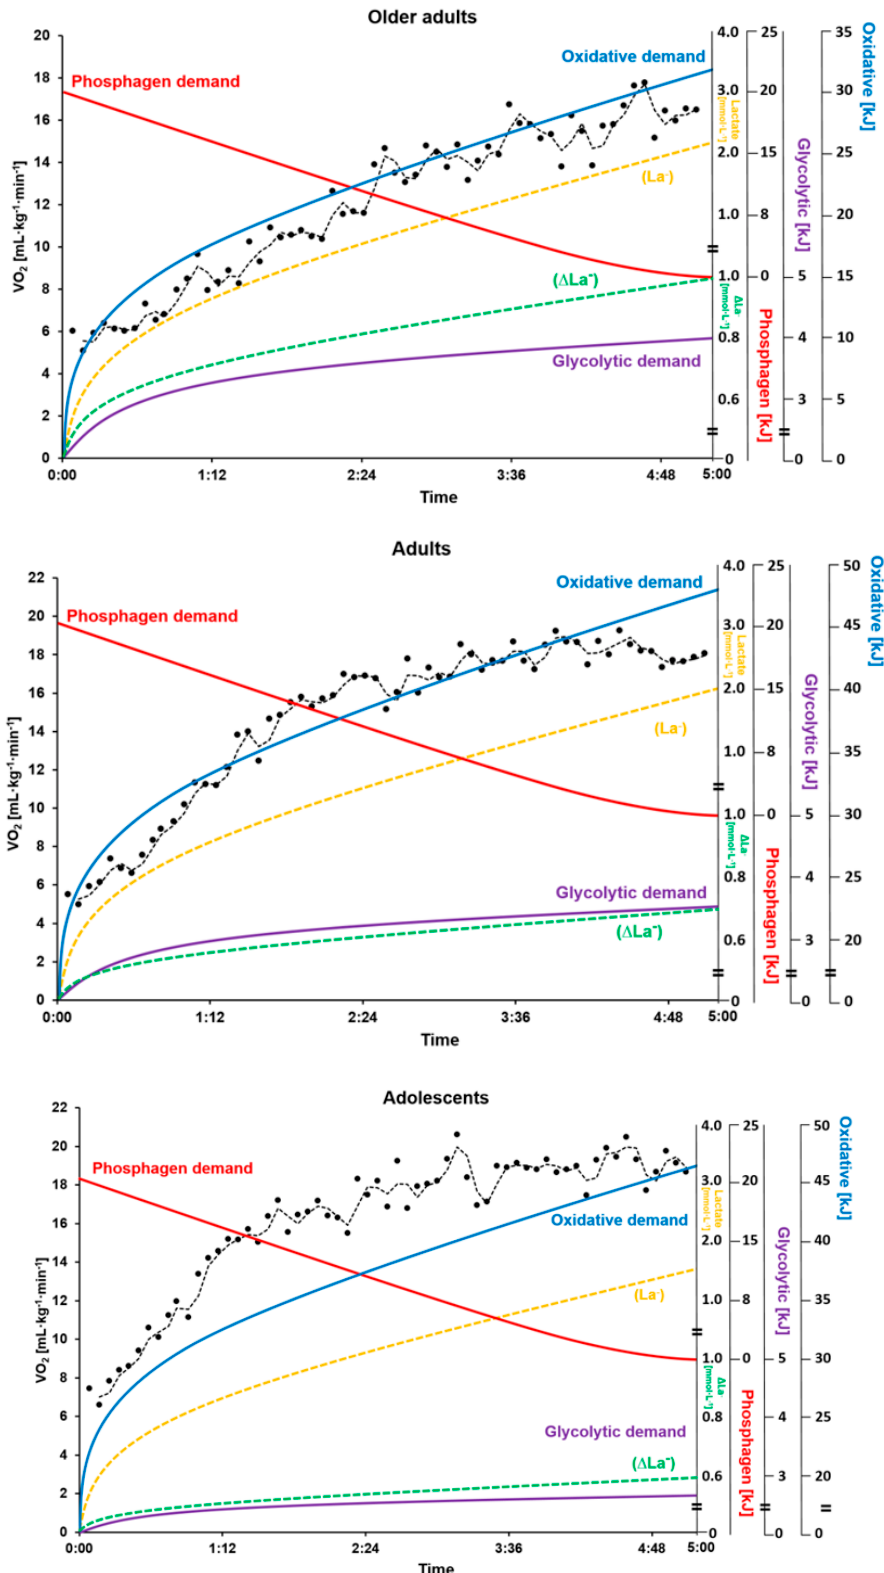
Figure 3. Mean contribution of each energy system during exergames in absolute values